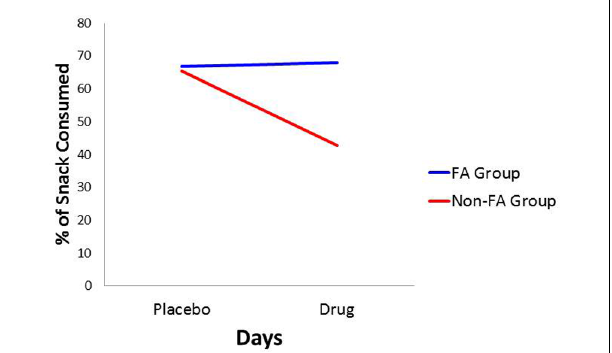
FIGURE 2 | Plot for the Diagnostic Group × Days interaction with appetite ratings as the dependent variable.